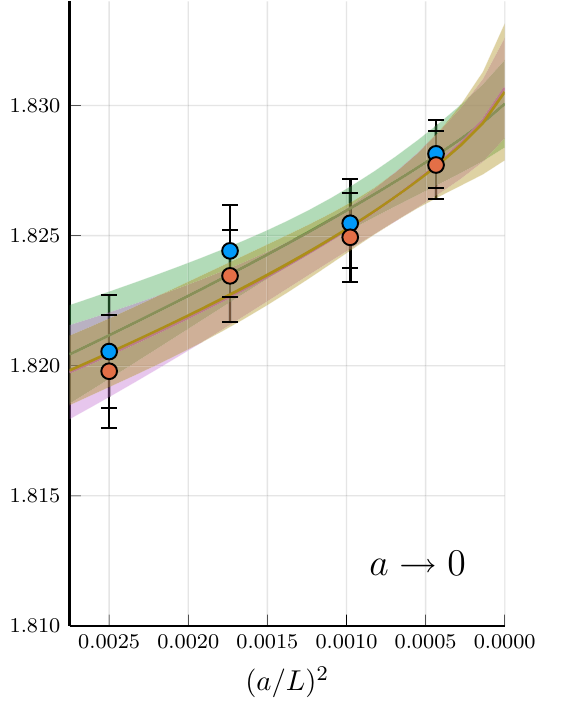
√ Fig. 7 Continuum extrapolation of J 1 ( u , a / use p 0 + p 1 ( a / L ) 2 log ( a / L ) , while for the case of the Wilson flow, we 8 t ) for u = 1 . 5. See text for discussion. Right: extrapolations of the Zeuthen flow data with a functional form of the type p 0 + p 1 ( a / L ) 2 . For the case of the Wil- son flow one can extend the fitting range by including a quadratic term in the extrapolation O ( a 4 ) . The extrapolated values show a reasonable agreement. Left: the same data is extrapolated including logarithmic terms in the functional ansatze. For the case of the Zeuthen flow we